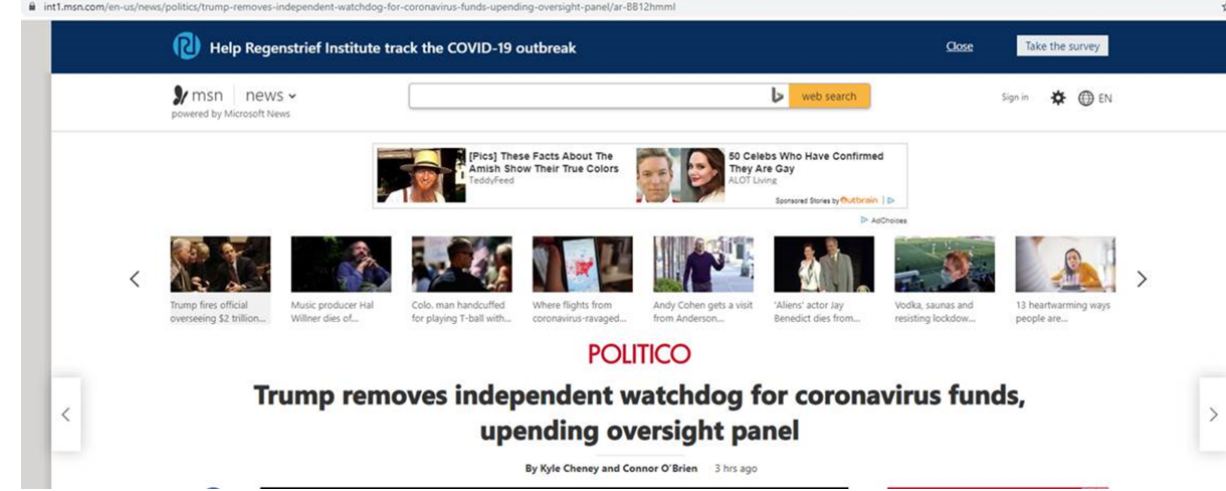
Figure 1. Screenshot of the Microsoft News platform showing the banner ad placed at the top of the screen that recruited participants to take a survey about COVID-19 symptoms and